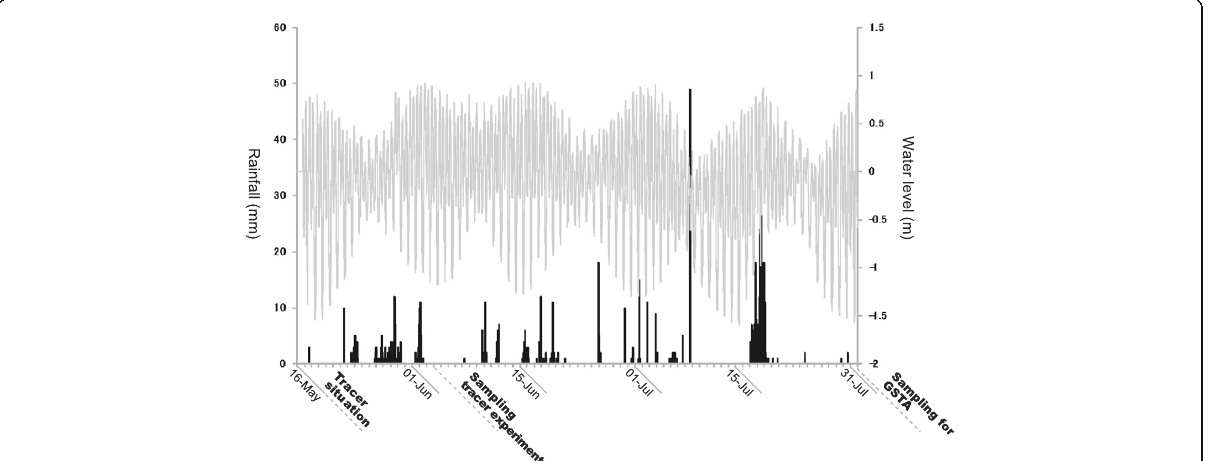
Fig. 3 The rainfall and water level of the Kushida River. The rainfall and the water level were measured respectively at the upper reaches ( ‘ R ’ in Fig. 1a) and at the river mouth ( ‘ W ’ in Fig. 1b) during a period from May 16 to July 31, 2011